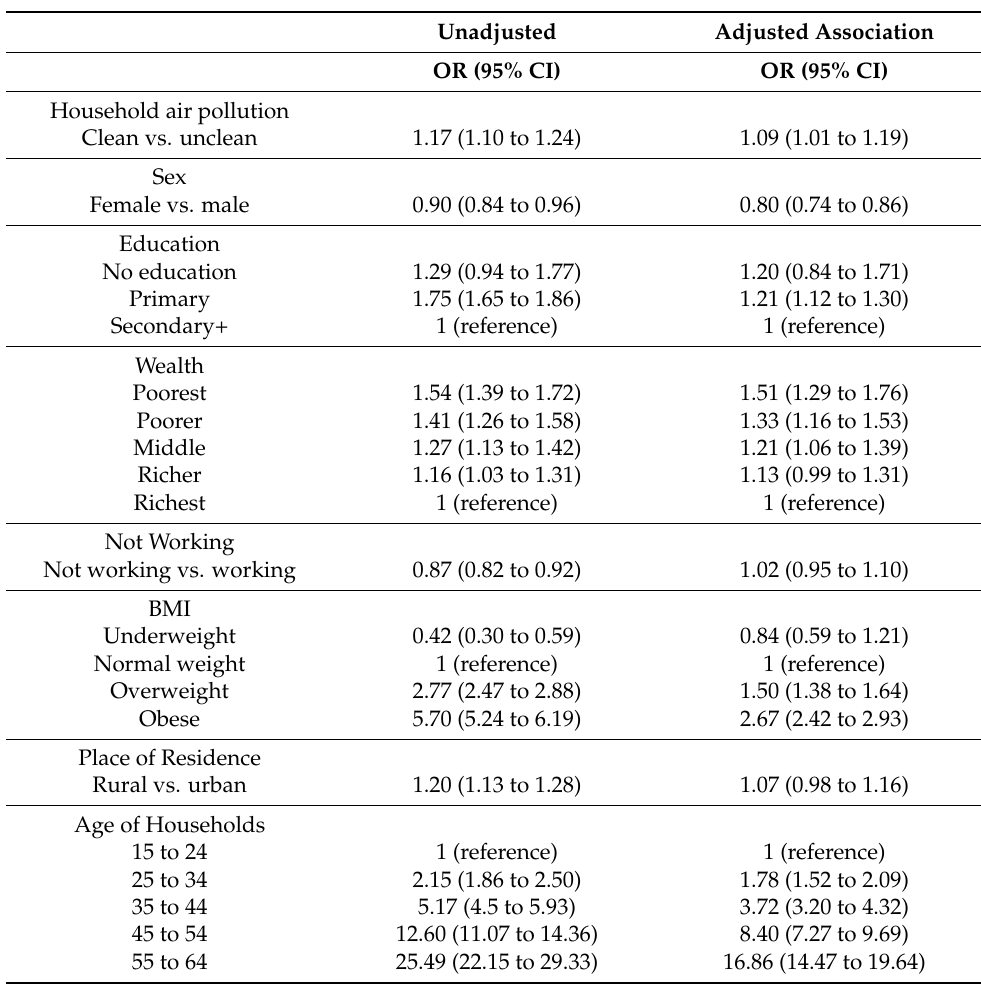
Table 2. Unadjusted and adjusted odds ratios of the association between high blood pressure, indoor air pollution, and selected